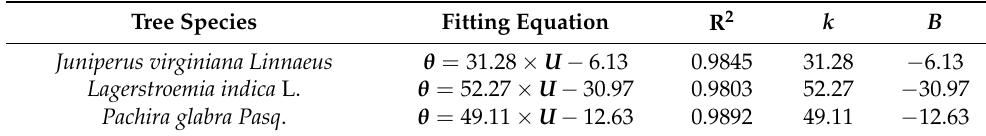
Table 2. Fitting equations for the values of the volumetric moisture content of the branches and the output voltage values of the measurement